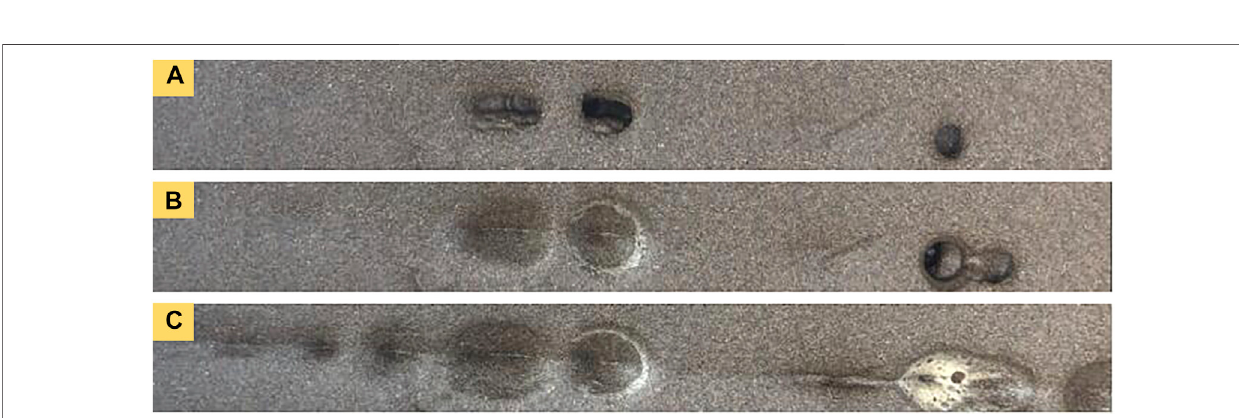
Frontiers in Earth Science |